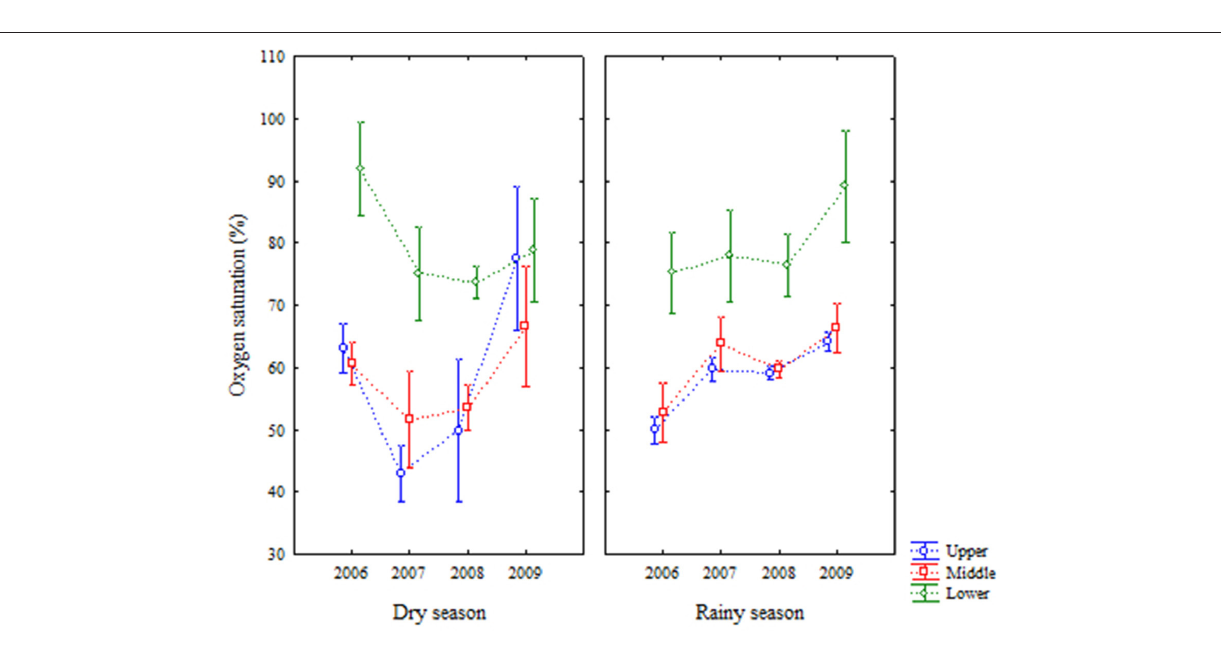
FIGURE 6 | Average ( ± standard deviation) of temporal (interannual and seasonal) variations of oxygen saturation at the Goiana River estuary from 2006 to